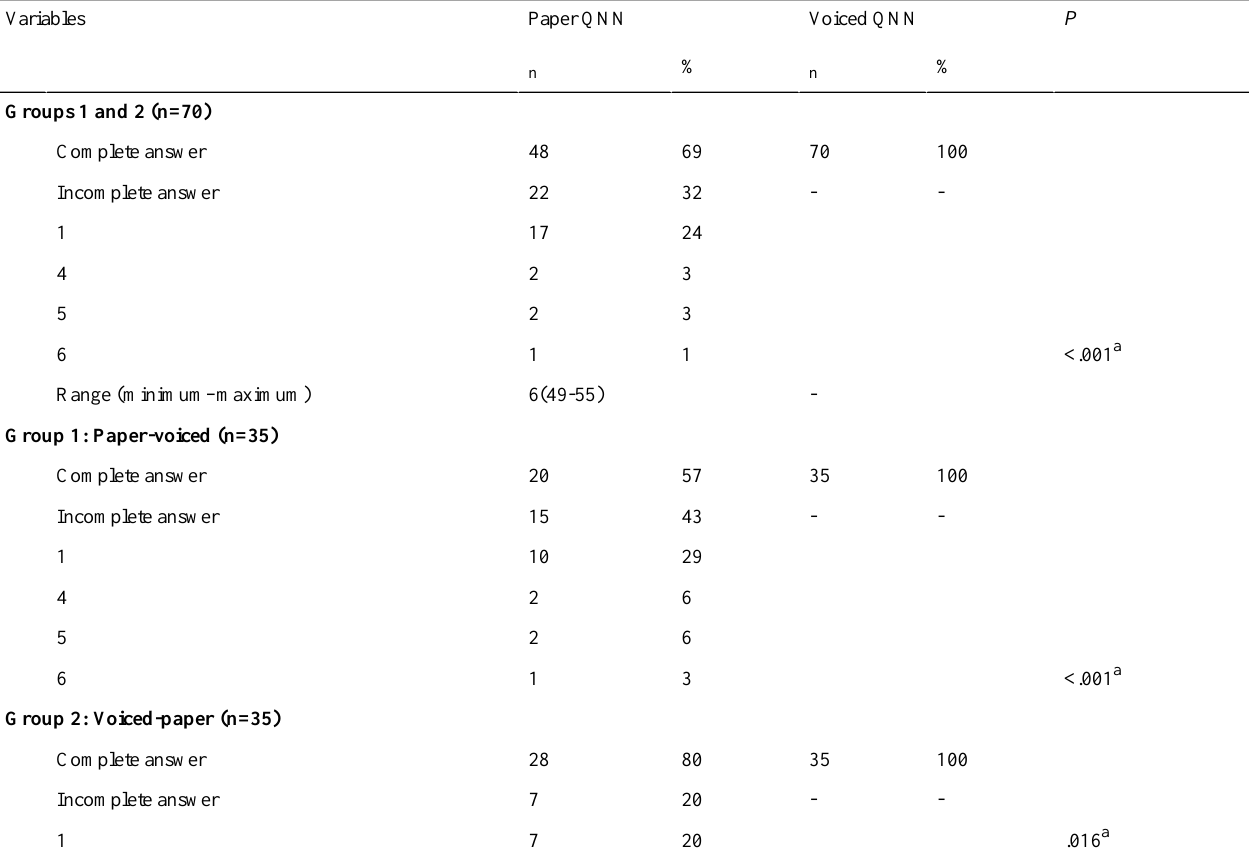
Table 1. Data completeness between paper-based and smartphone voiced questionnaire survey methods.